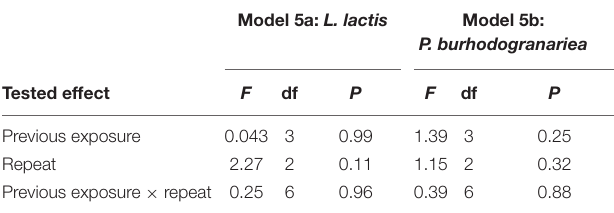
TABLE 3 | The effects of previous exposure and experimental repeat on bacterial load on day seven